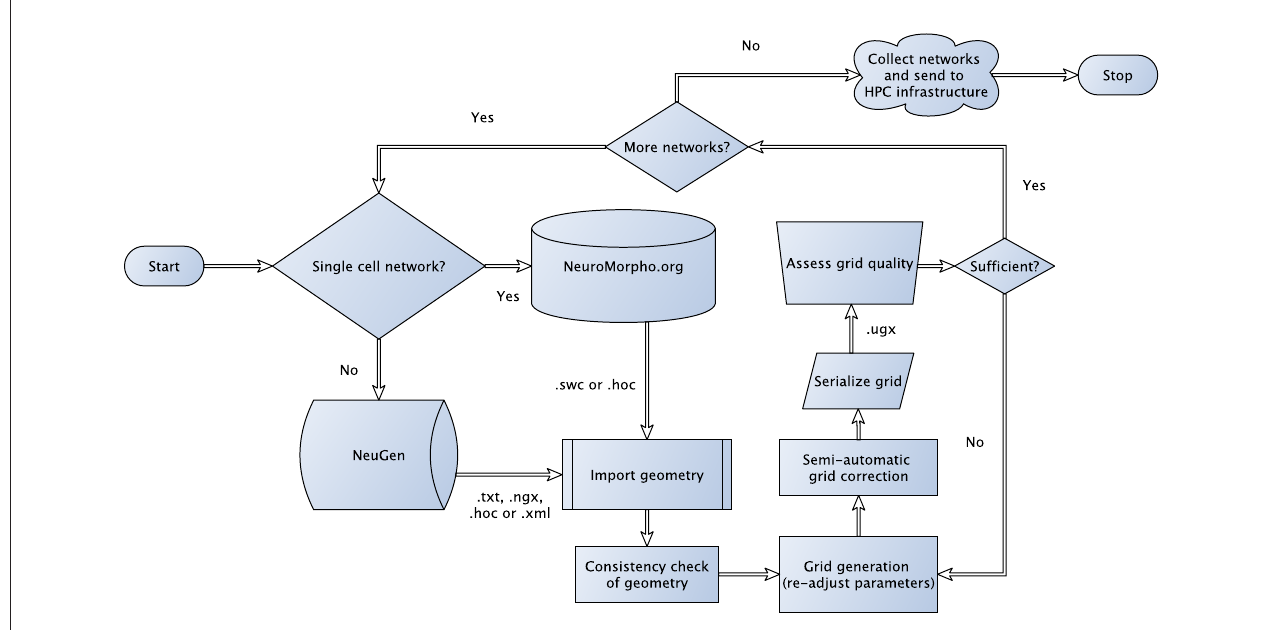
FIGURE 1 | Flowchart sketching the streamlined pipeline for the generation and subsequent transformation of neuronal network morphologies to grids suitable for large-scale network simulations. In case of three-dimensional simulations, where one-dimensional point/line reconstructions are used to generate three-dimensional representations (see Grein et al., 2014) quality assessment of the generated grid can be performed in a semi-automatic way to allow for the best possible preparation for the subsequent numerical simulations, for instance, we check for intersecting dendrites introduced during neuron tracing.